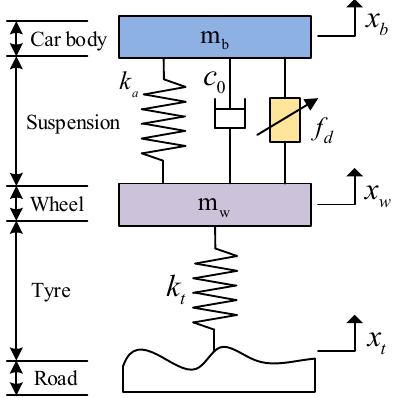
Figure 12. Model of quarter vehicle air suspension.